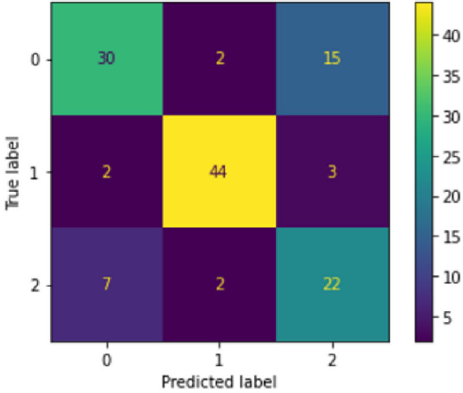
Figure 3. Confusion matrix of PCA+RF at second-level